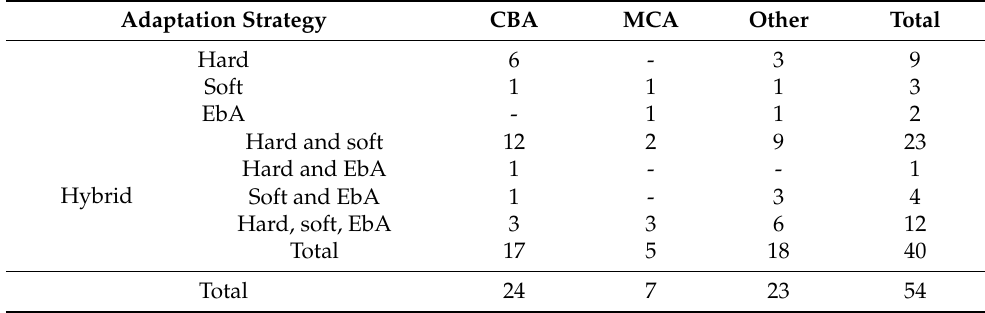
Table 5. Number of reviewed studies per adaptation strategy and socio-economic method considered. Adaptation Strategy CBA MCA Other Total Hard 6